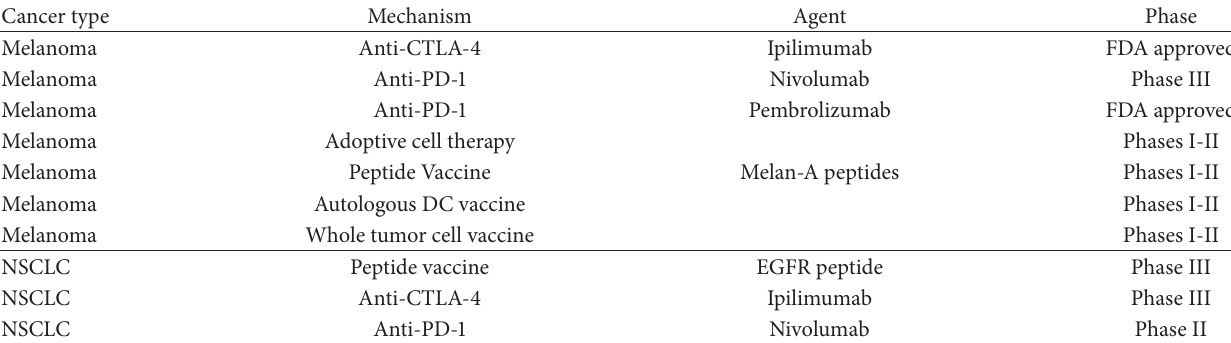
Table 1: Stage of clinical development of immunotherapeutics in select